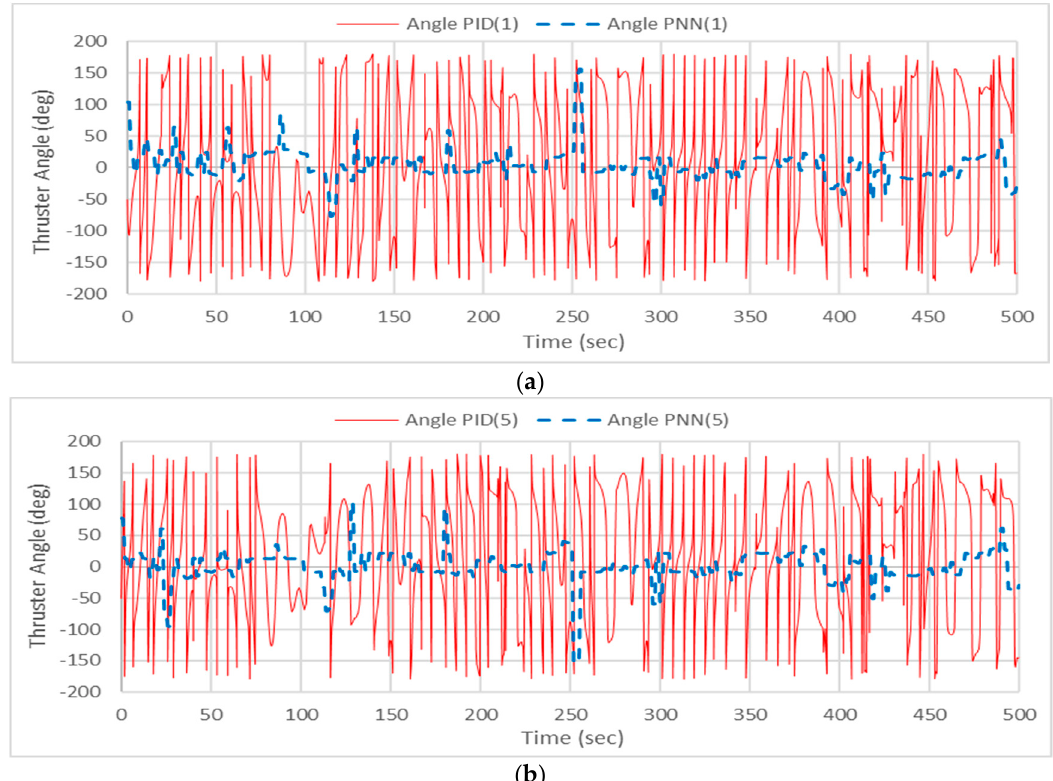
Figure 23. DP simulation with PID and PNN controls showing thruster angle (Beam sea): ( a ) Thruster 1; ( b ) Thruster 5.